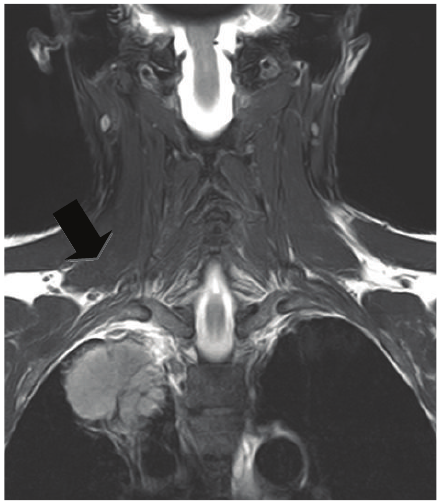
Figure 4: This TSE T2W image on the coronal plane shows the integrity of the anatomical structures of the superior sulcus (full black arrow).